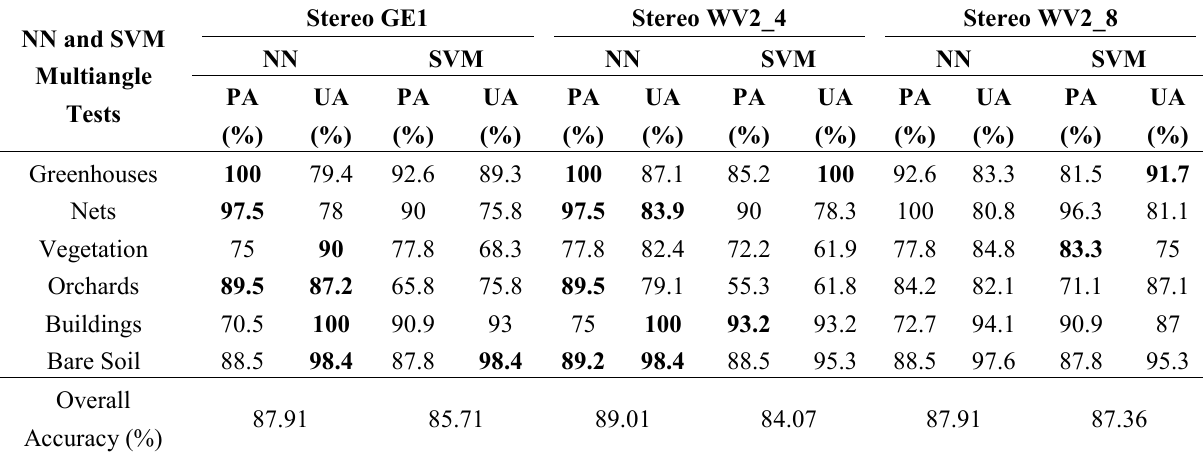
Table 6. PA and UA per class attained for each stereo test by using the NN or SVM classifier and the all features